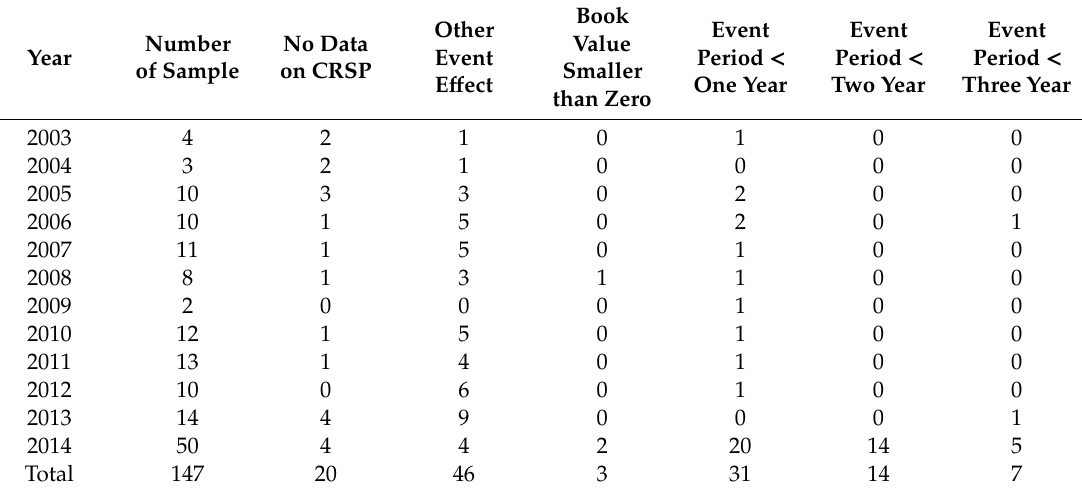
Table 3. Sample selection criteria for